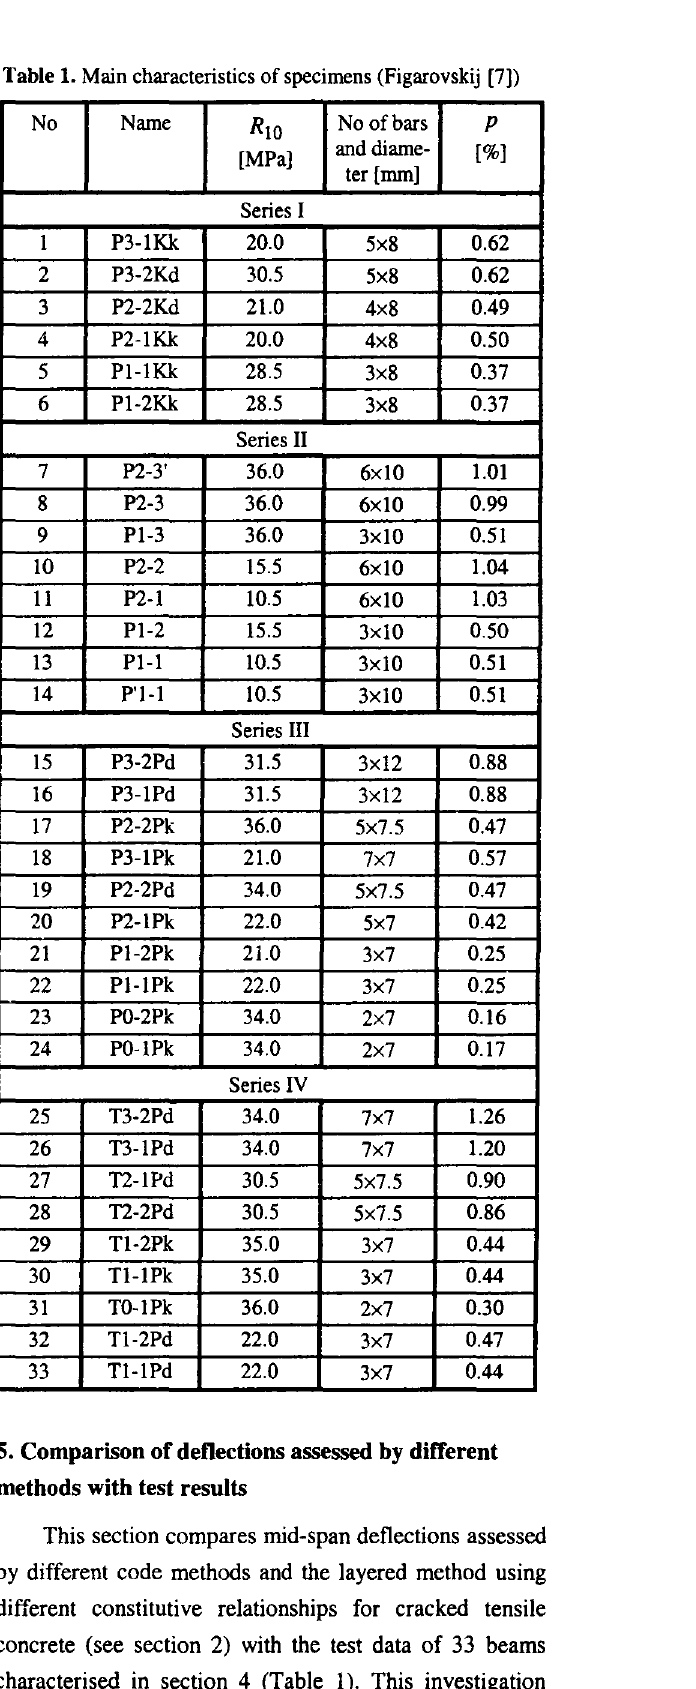
Table 1. Main characteristics of specimens (Figarovskij